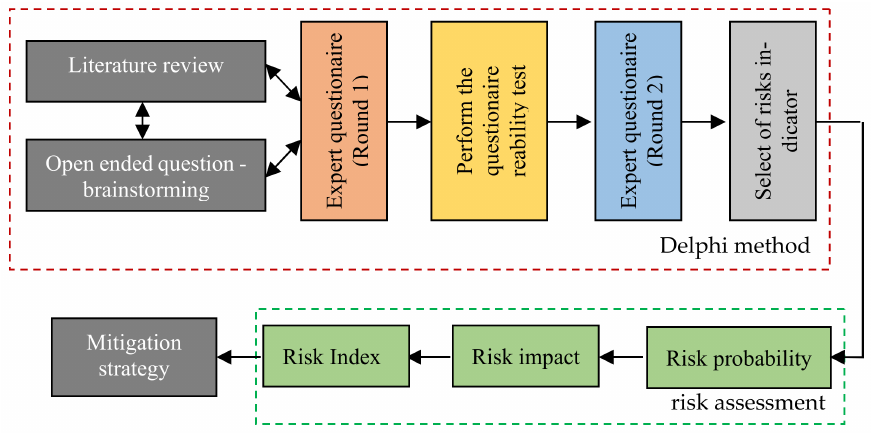
Figure 5. Research Framework.